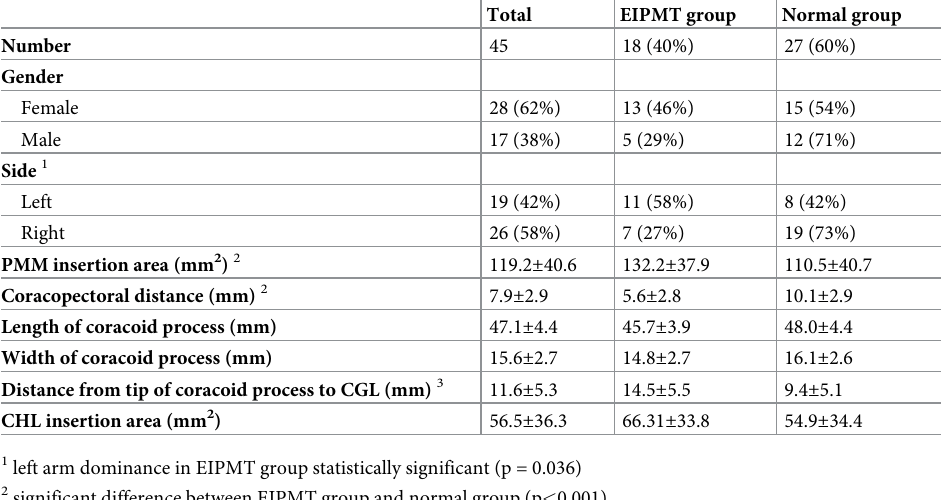
Table 1. Dimensions of and relationships between shoulders with (EIPMT) and without (Normal) ectopic inser- tions. CGL = coracoglenoid ligament CHL = coracohumeral ligament, PMM = pectoralis minor muscle.